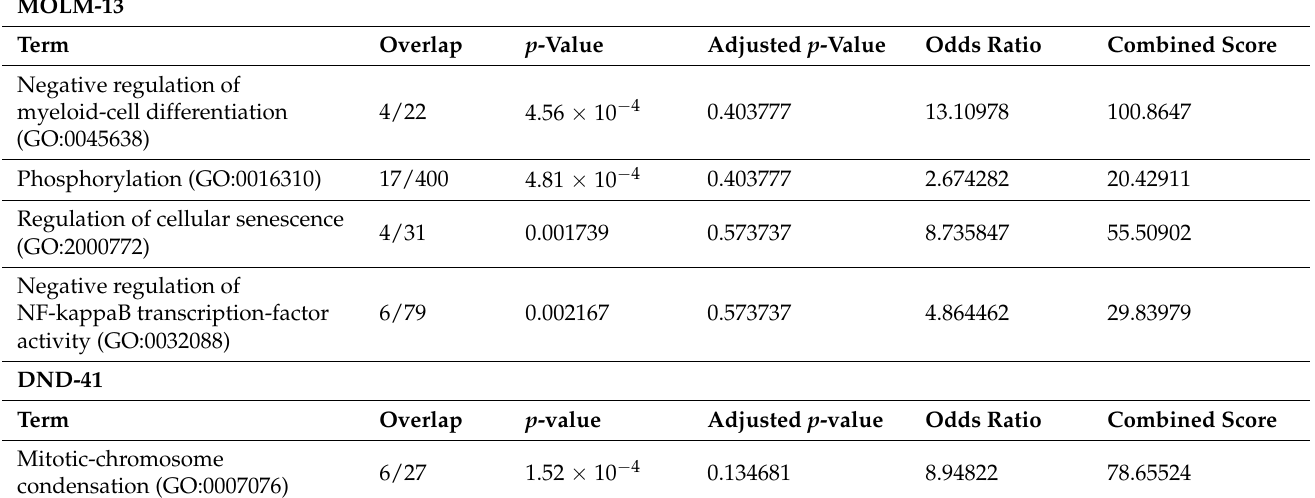
Table 2. GO terms (biological processes) for genes with the broadest H3K79me2 domains unique to one of the four cell